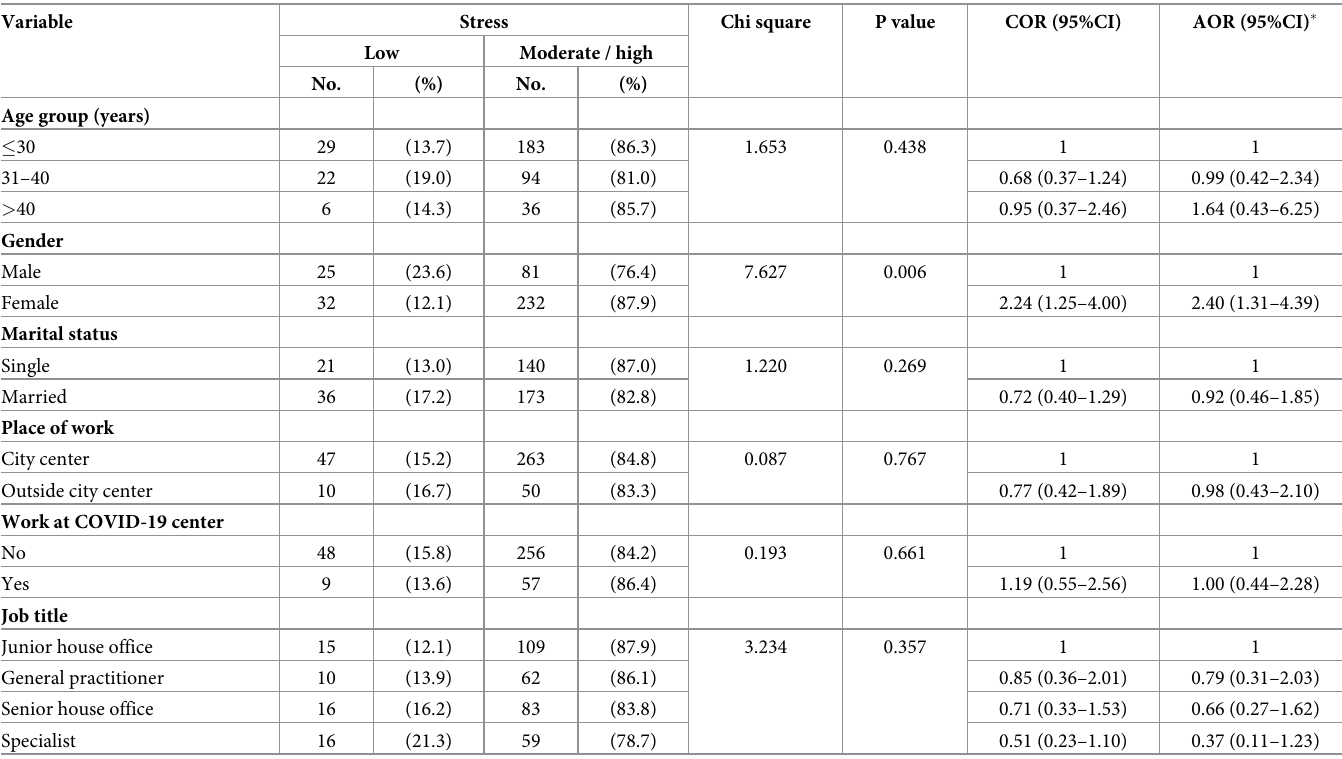
Table 4. Factors associated with perceived stress among physicians.